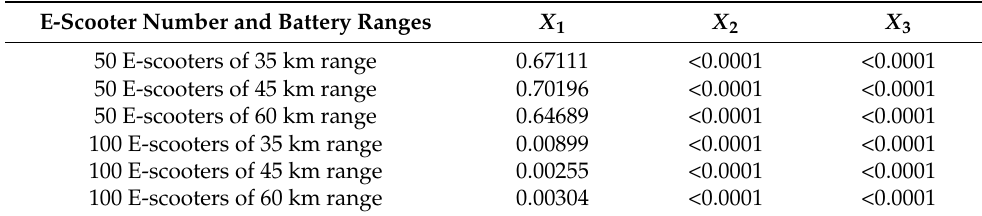
Table 3. p values of the scenario’s indicator variables for the HI Table 3. P values of the scenario’s indicator variables for the HI models.